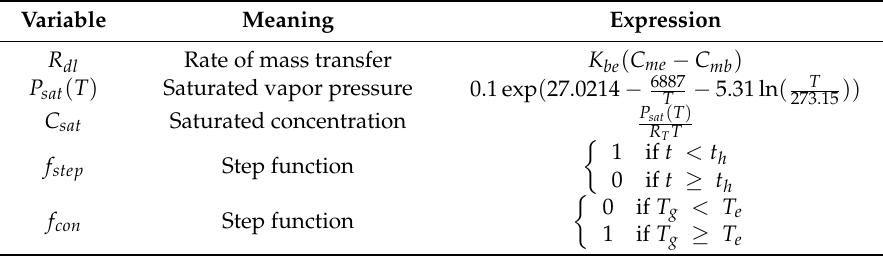
Table 2. Variables equations used in this